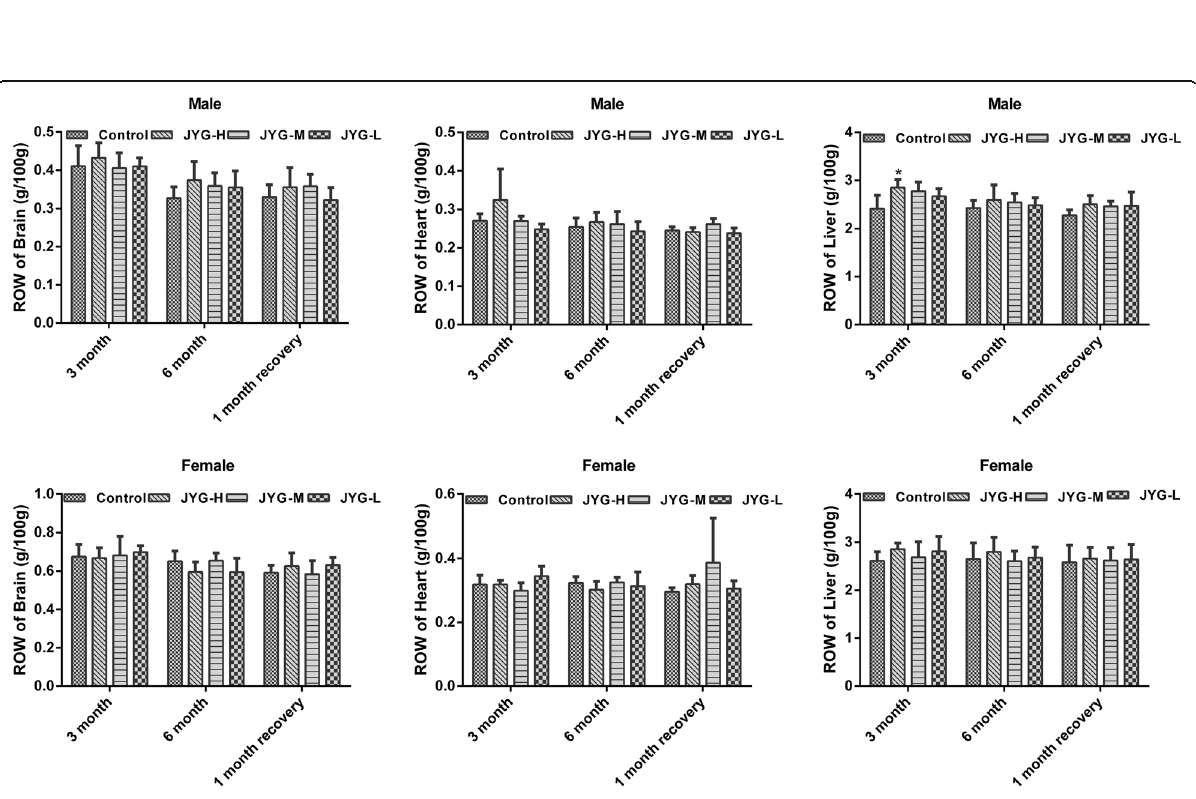
Fig. 6 Relative organs weight of brain, heart and liver in the control and JYG-treated groups in the chronic toxicity test. Note: ROW: relative organs weight; JYG-H, JYG-M, JYG-L: Jueyin granules high-dose, medium dose, low-dose group, respectively. The values are expressed as mean±SEM (n=10 rats for 3 months; n=17 – 19 rats for 6 months; n=10 rats for 1 month recovery). * P <0.05 statistically significant compared to control